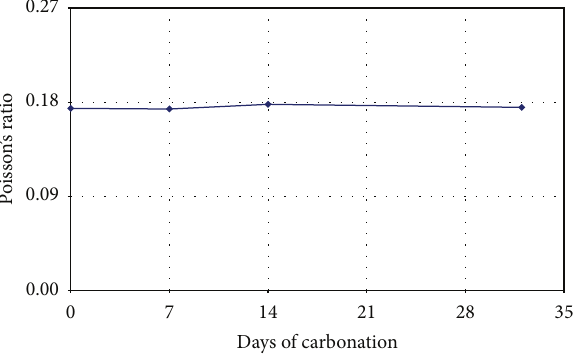
Figure 13: Evolution of the longitudinal ultrasonic velocity ( 𝑉 𝐿 ) during carbonation.